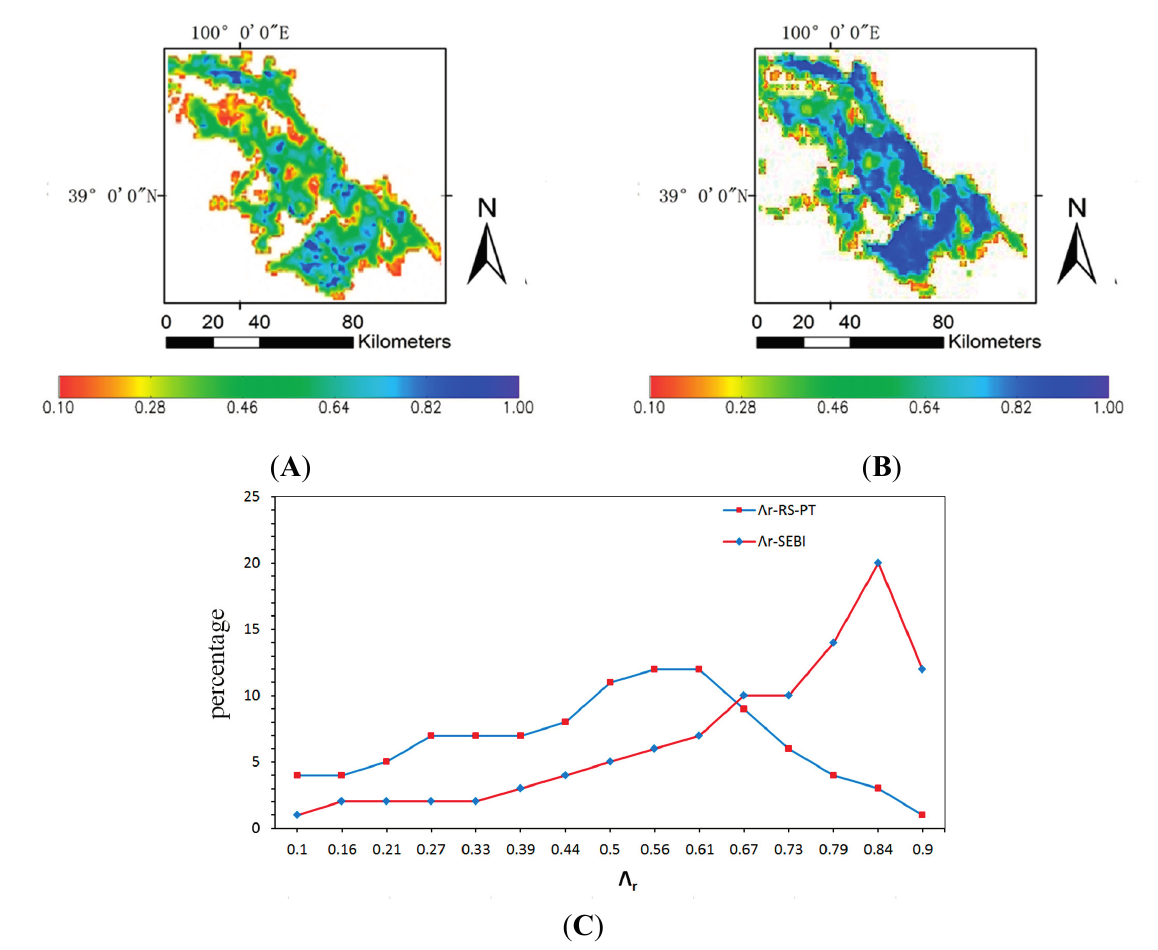
Figure 9. The spatial pattern and frequency curves of Λ r derived from different methods over the Zhangye Oasis, using the same data as in Figure 8: ( A ) Λ r is the result from the statistical dry/wet boundaries based on LST-Fc feature space ( Λ r -RS-PT); ( B ) Λ r is calculated based on SEBI ( Λ r -SEBI); and ( C ) the frequency curves of Λ r for (A) and (B).